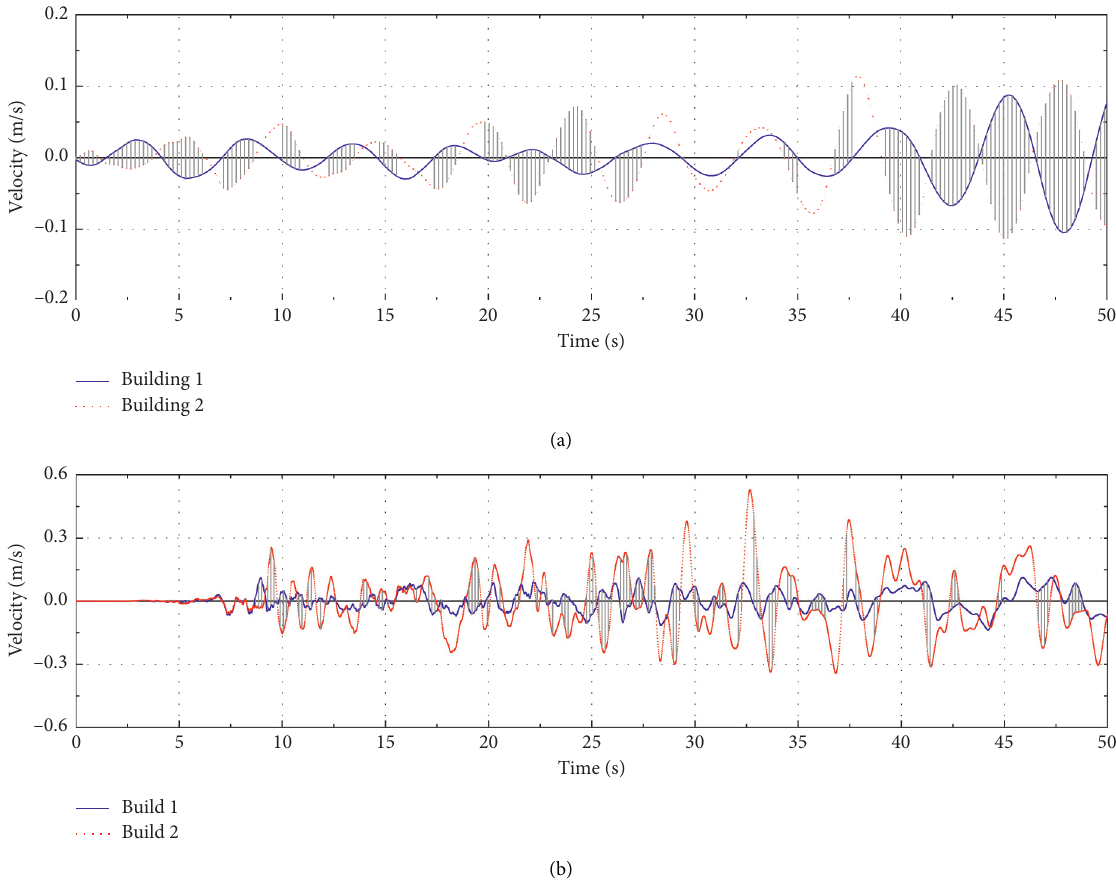
Figure 9: Time histories of velocity responses at 210.2 m height under (a) 90 ° wind direction and (b) the No. 10 earthquake excitation.